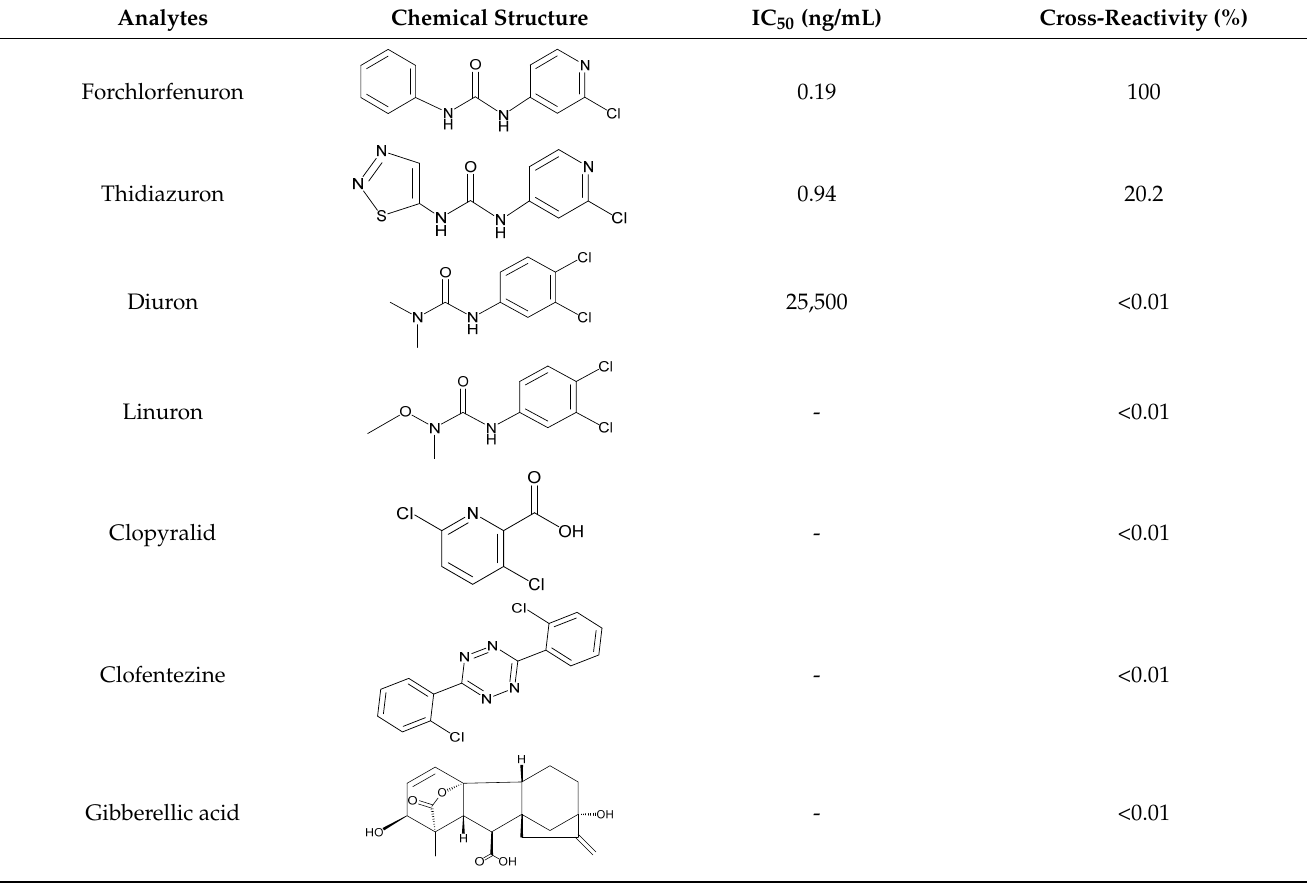
Table 3. Cross-reactivity (CR) of CPPU and other structural analogs.